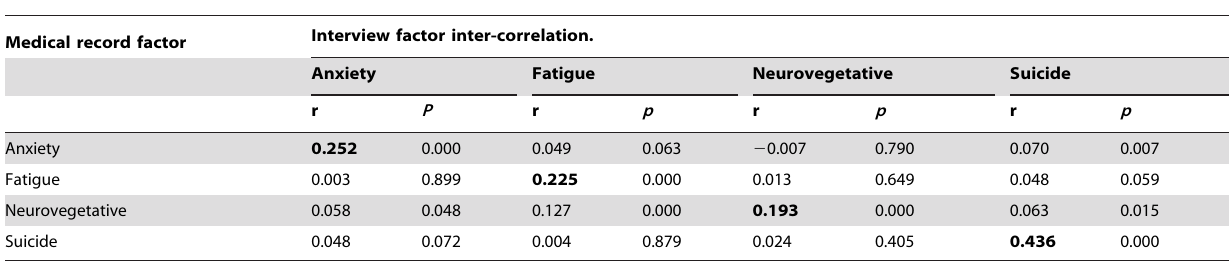
Table 5. Correlation between MD Symptom Factors Derived from Personal Interview And Medical Records.